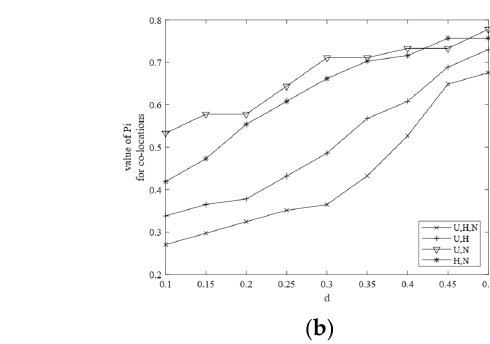
Figure 10. ( a ) Pi of (cid:4668)𝑈 , 𝐻 , 𝐿(cid:4669) , (cid:4668)𝑈 , 𝐻(cid:4669) , (cid:4668)𝑈 , 𝐿(cid:4669) and (cid:4668)𝐻 , 𝐿(cid:4669) ; ( b ) Pi of (cid:4668)𝑈 , 𝐻 , 𝑁(cid:4669) , (cid:4668)𝑈 , 𝐻(cid:4669) , (cid:4668)𝑈 , 𝑁(cid:4669) and (cid:4668)𝐻 , 𝑁(cid:4669) .